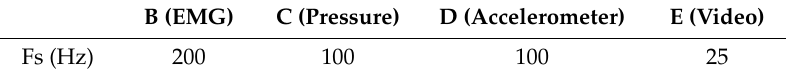
Table 1. Sampling frequency ( Fs ) for sensors B ÷ E.